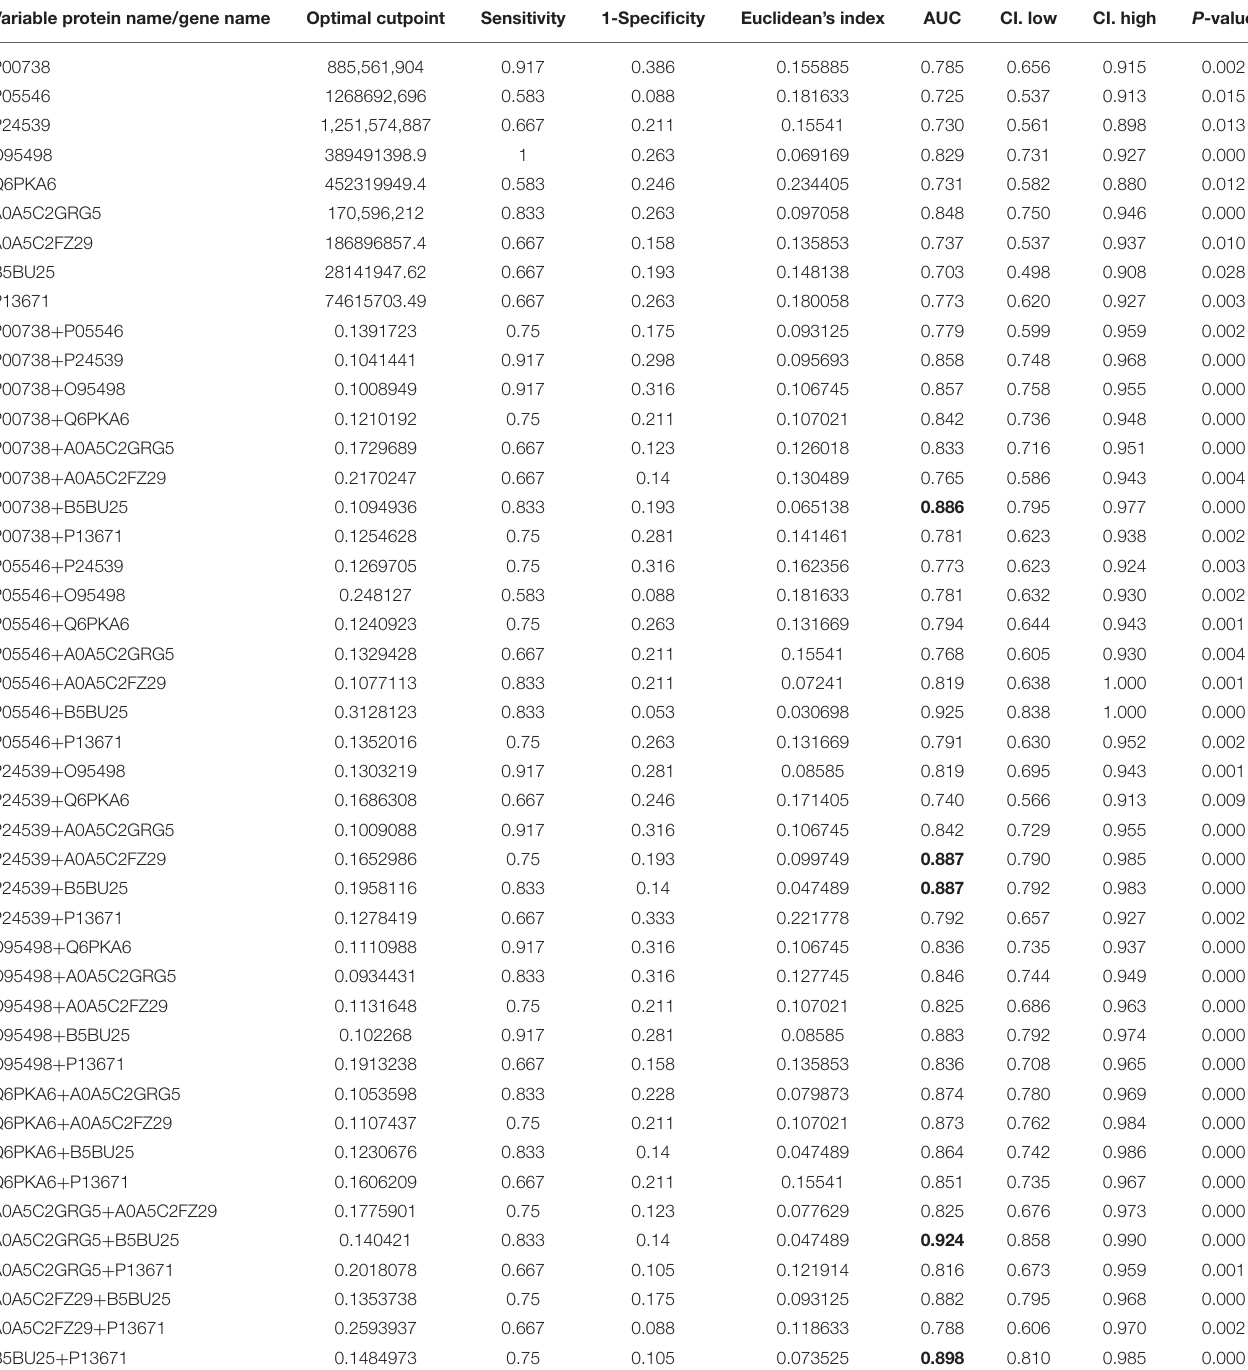
TABLE 3 | AUC statistics per protein and combined proteins, for the classification status of DVD group from other